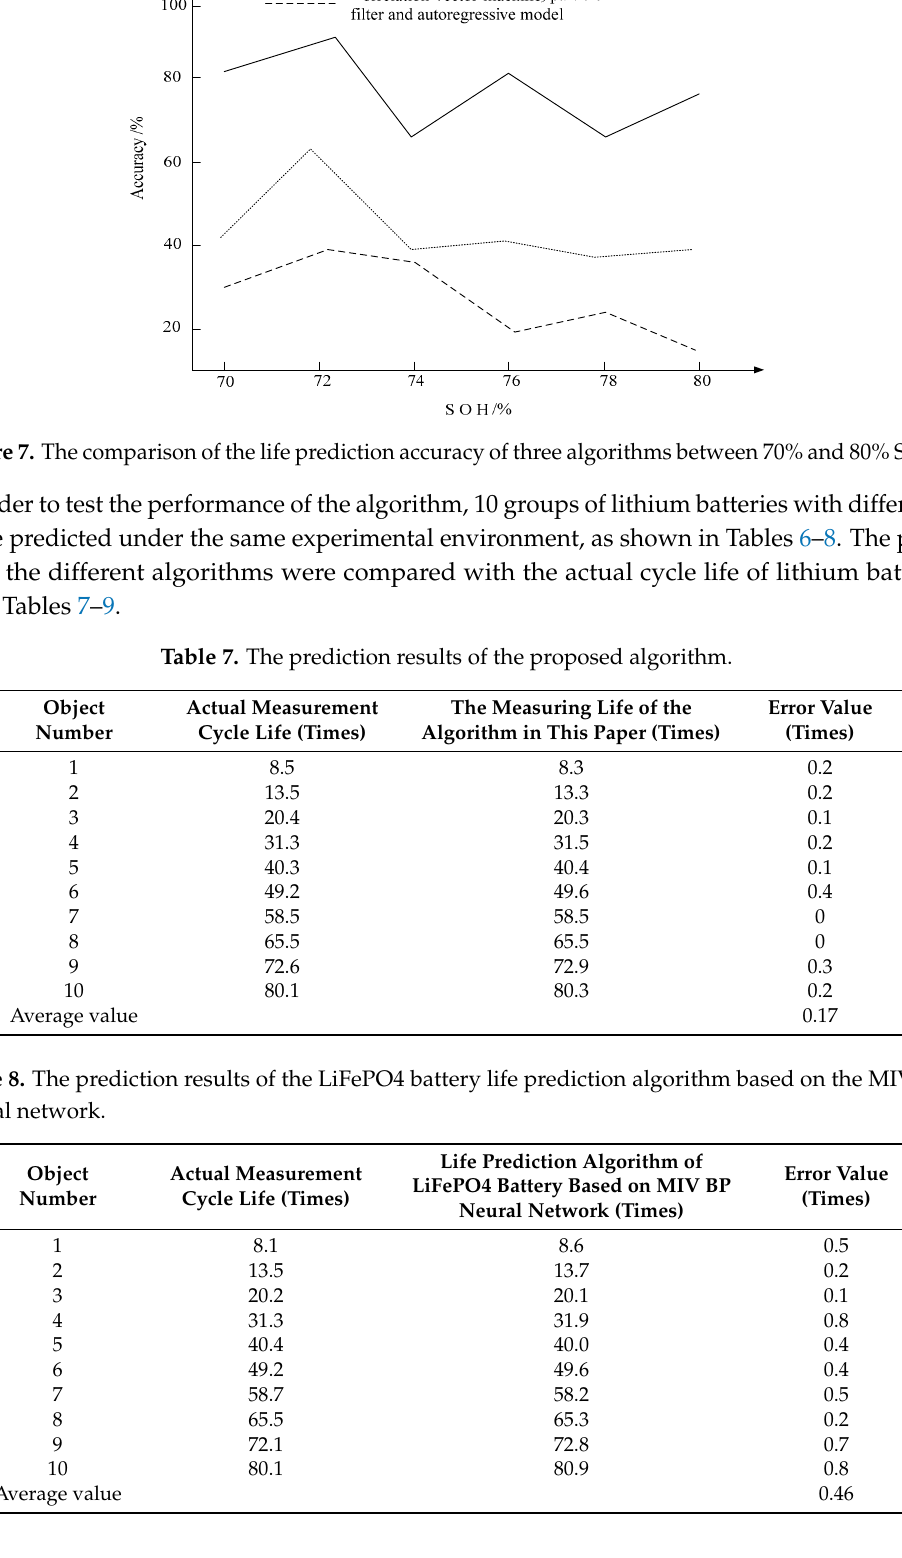
Table 8. The prediction results of the LiFePO4 battery life prediction algorithm based on the MIV BP neural network.